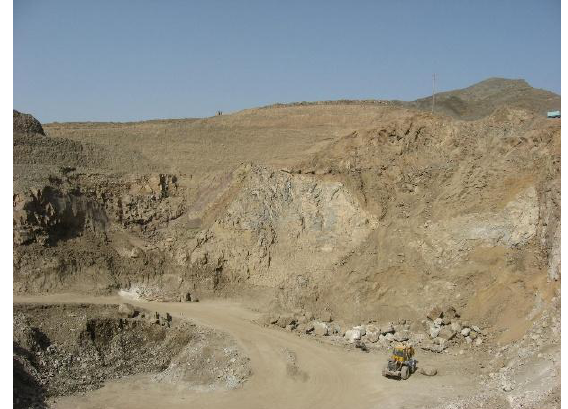
Figure 1. Open-pit mining area.